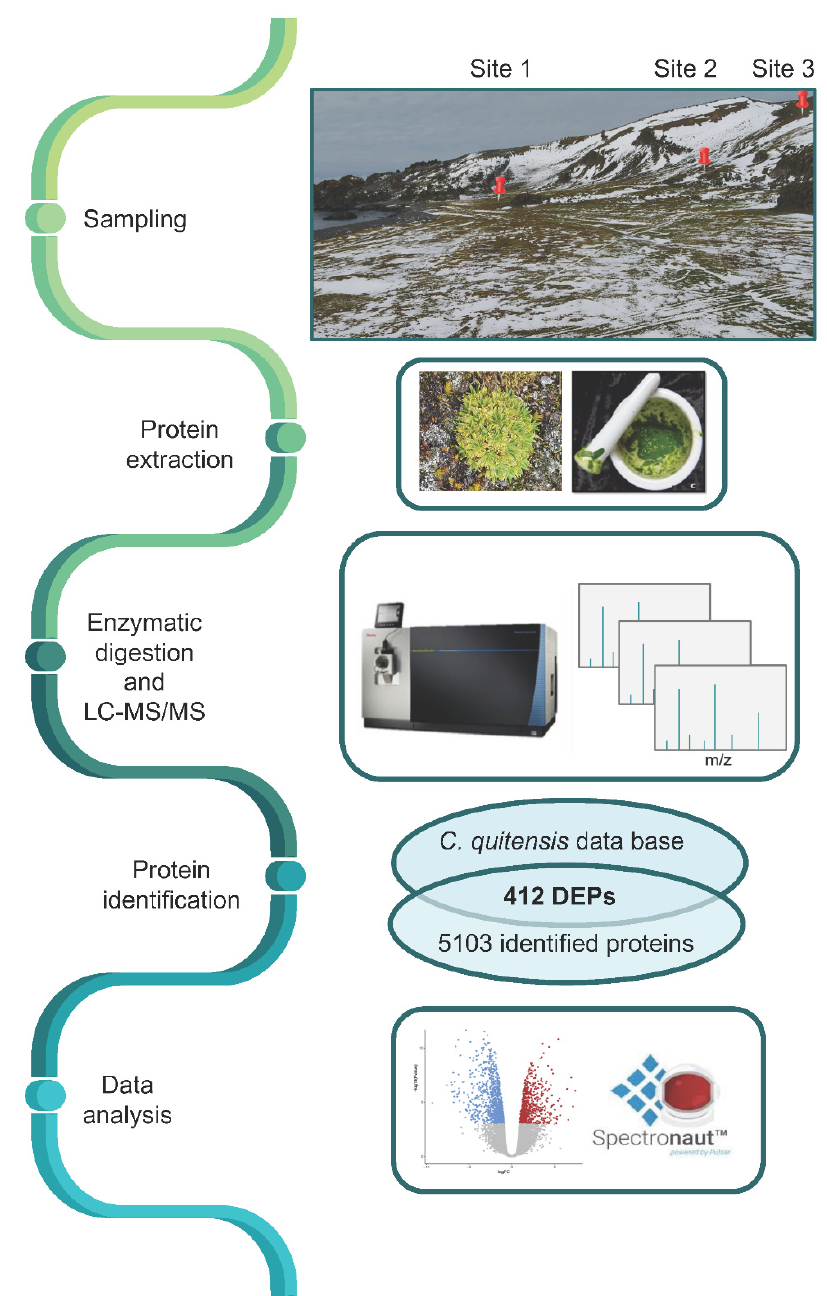
Figure 1. Experimental workflow (left); pictures on the right refer to each step of the workflow.